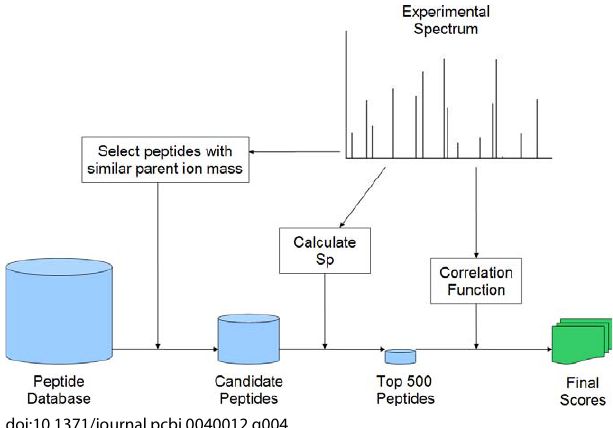
Figure 4. A Simplified Flowchart for the Sequest Algorithm Showing the Process by which Sequest Provides Scores Used to Identify Peptides Flowchart shows process as described in United States patent 6,017,693 [56]. Note that information from the mass spectrum is used three times: (1) as a filter to select only peptides from the database sharing a similar parent ion mass with the unknown peptide; (2) during a preliminary Sp ‘‘ closeness-of-fit ’’ filter to select the top 500 peptide candidates; and (3) through a correlation function to produce the final